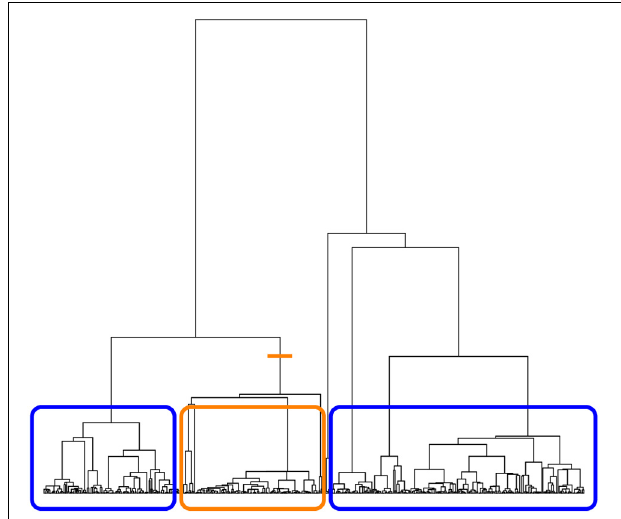
FIGURE 1 | Illustration of bipartition clustering. The tree is cut at an internal branch of the tree (orange line). The tips of the tree descending from that branch form one group (orange box) and the tips of the tree that do not descend from that branch form the second group (two blue